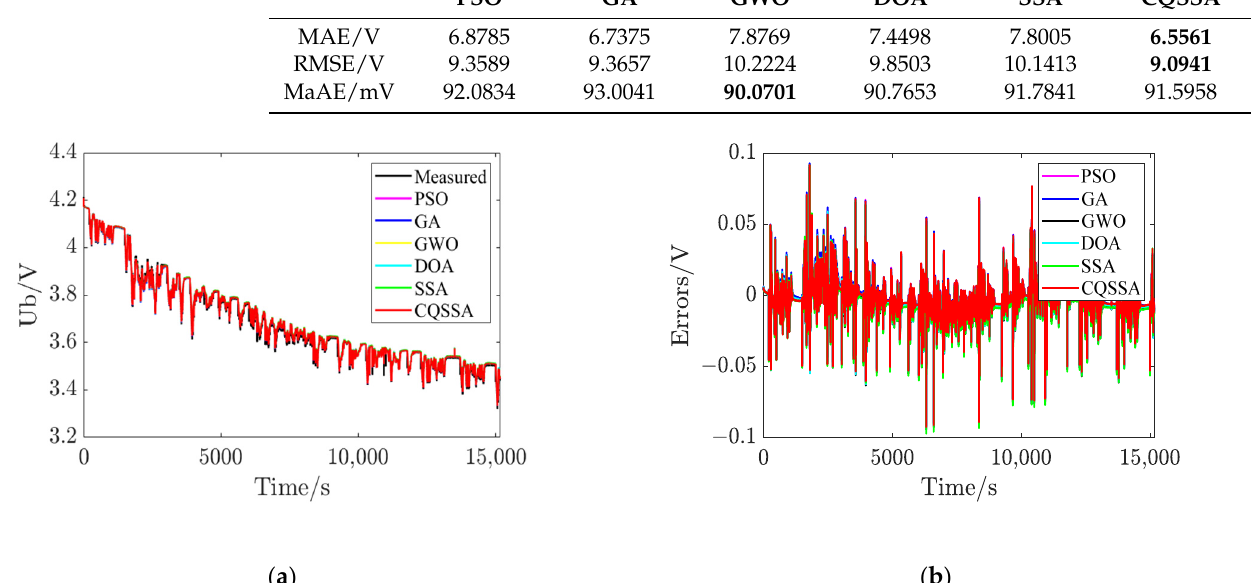
Table 8. Terminal voltage errors with six different groups of FOM parameters under UDDS test. PSO GA GWO